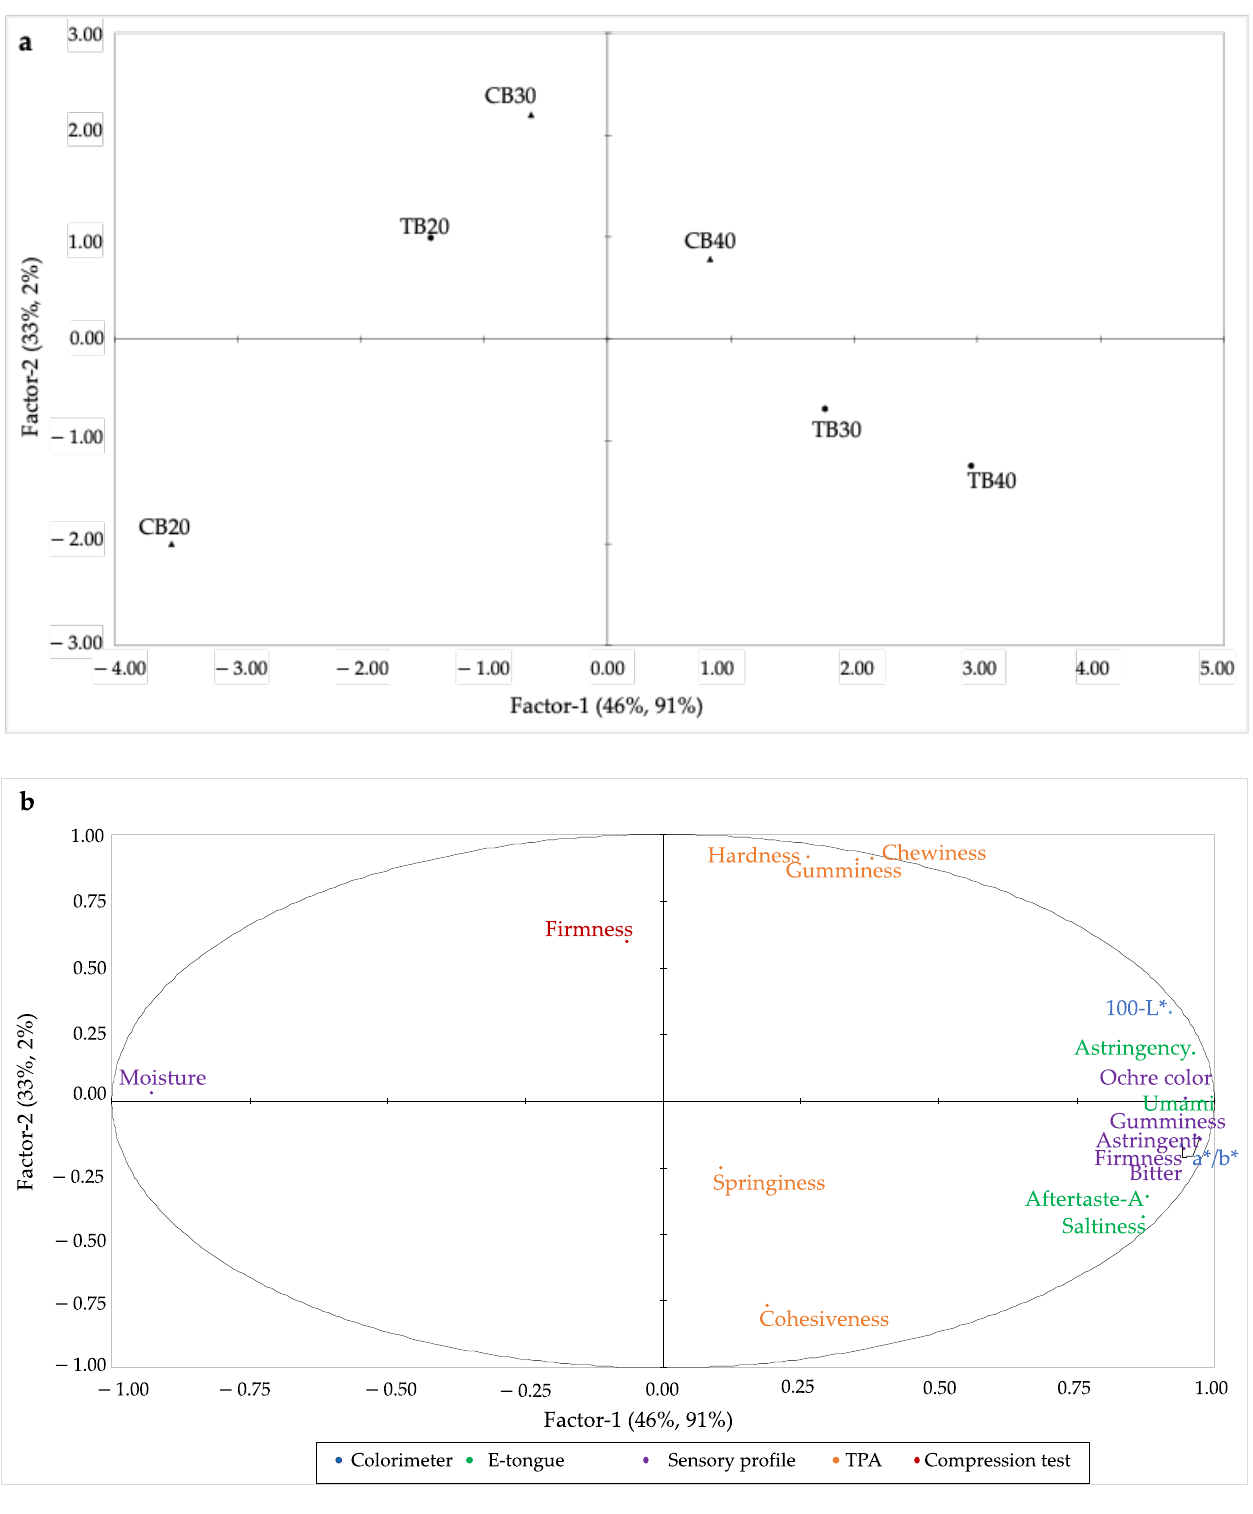
Figure 4. Score plot ( a ) and loading plot ( b ) obtained by the PLSR model of sensory analysis and instrumental determinations for each sample (CB20, CB30, CB40, TB20, TB30, TB40) (CB = common buckwheat; TB = Tartary buckwheat). Aftertaste-A = aftertaste-astringency. As regards texture dimension, sensory data revealed that TB30 and TB40 samples were described according to sensory firmness and gumminess, as well as springiness